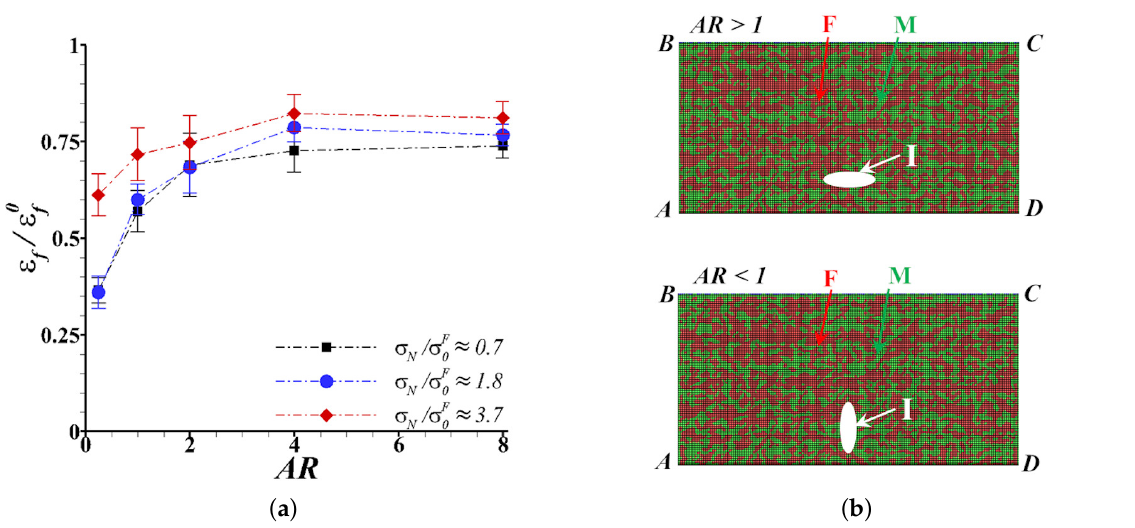
Figure 9. ( a ) Effect of the aspect ratio ( AR ) of an elliptical inclusion on the flexural strain to failure, ε f , (i.e., bendability) of the dual-phase steel. The cross-section area of the inclusion, A ≈ 25 π e 2 (giving inclusion center, dy / d = 0.125, is fixed in all the calculations. ( b ) Schematic of elliptical inclusions with aspect ratio (AR) greater than (top) and less than (bottom)